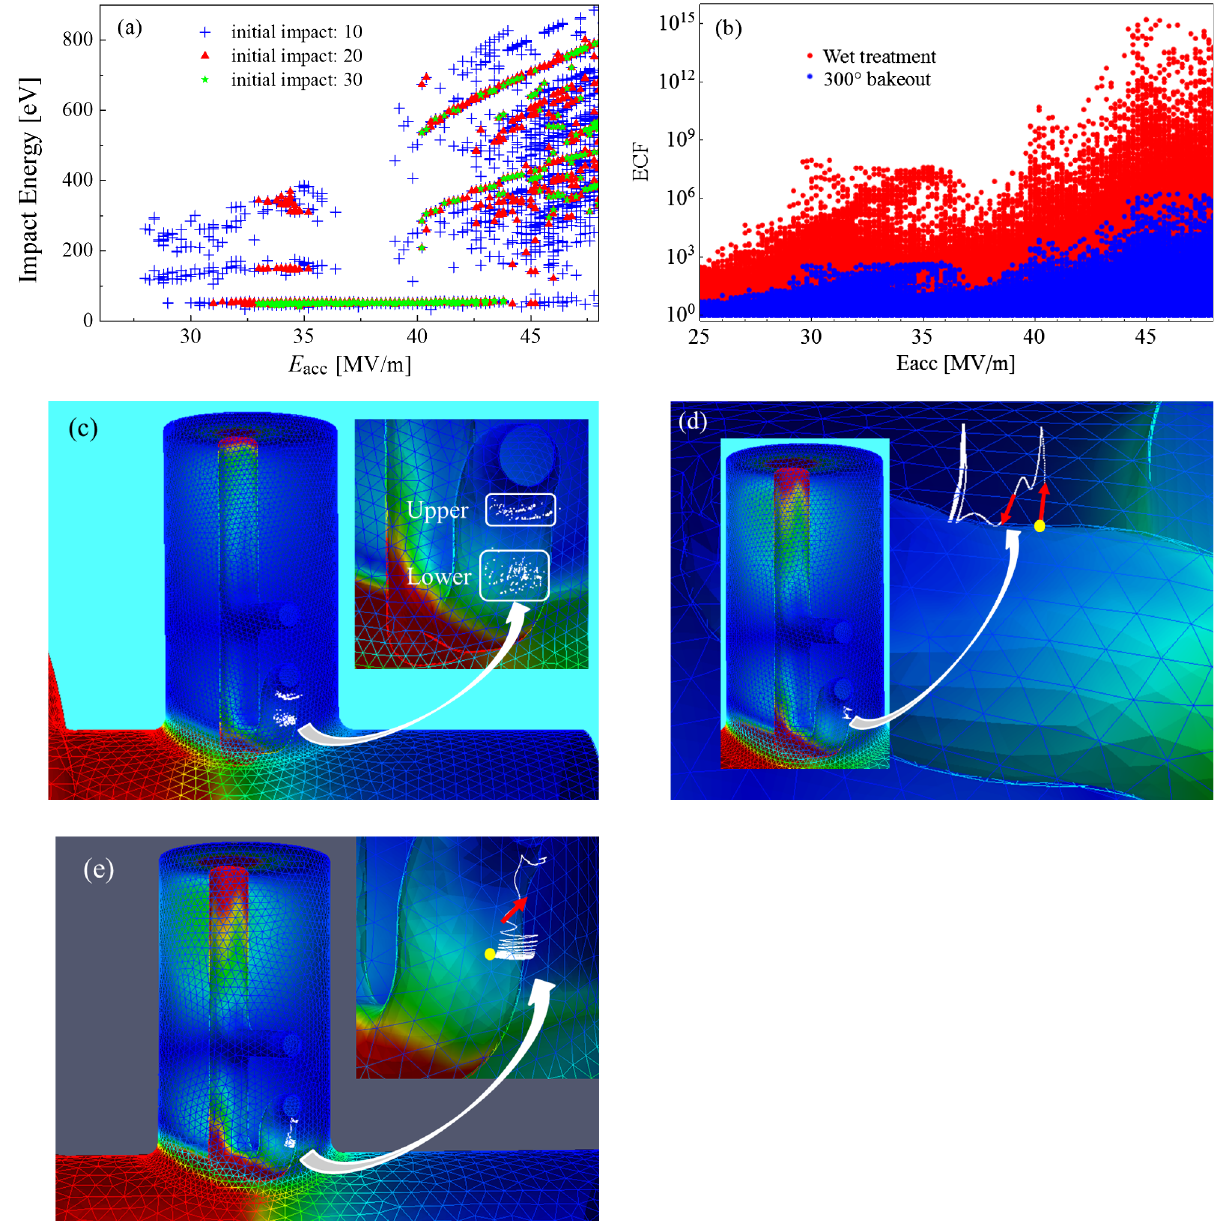
FIG. 7. Characteristics of zone 3 MP: (a) electron impact energy; (b) enhancement counter function after 20 rf periods; (c) two MP regions; (d) typical low impact energy resonant electron (upper region) trajectories. The emission site is indicated by the yellow dot. The initial movement direction of the MP electron is indicated by red arrows. The ultimate resonant trajectory between the two surfaces with impact energy of ∼ 50 eV is also shown. (e) Typical high impact energy resonant electron (lower region) trajectories. The MP electron ultimately slips out of